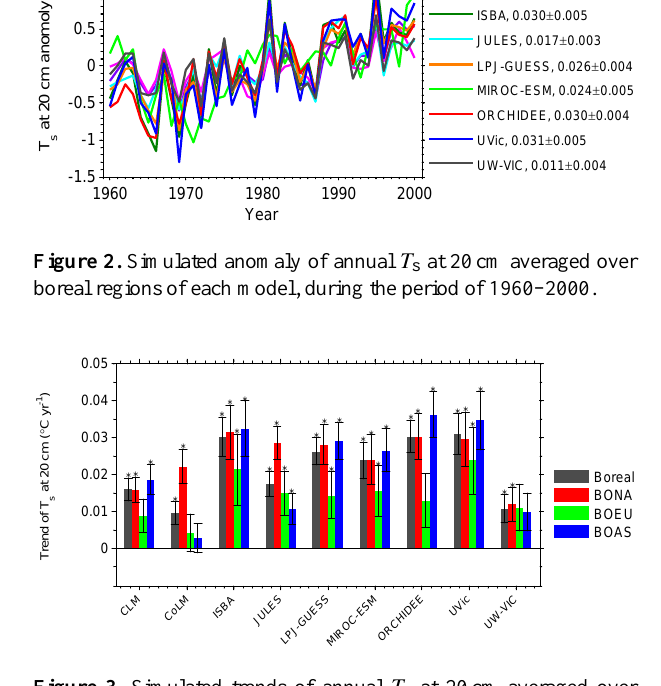
Figure 3. Simulated trends of annual T s at 20cm averaged over boreal regions and sub-regions of each model, from 1960 to 2000. ∗ indicates significant trend of T s ( P